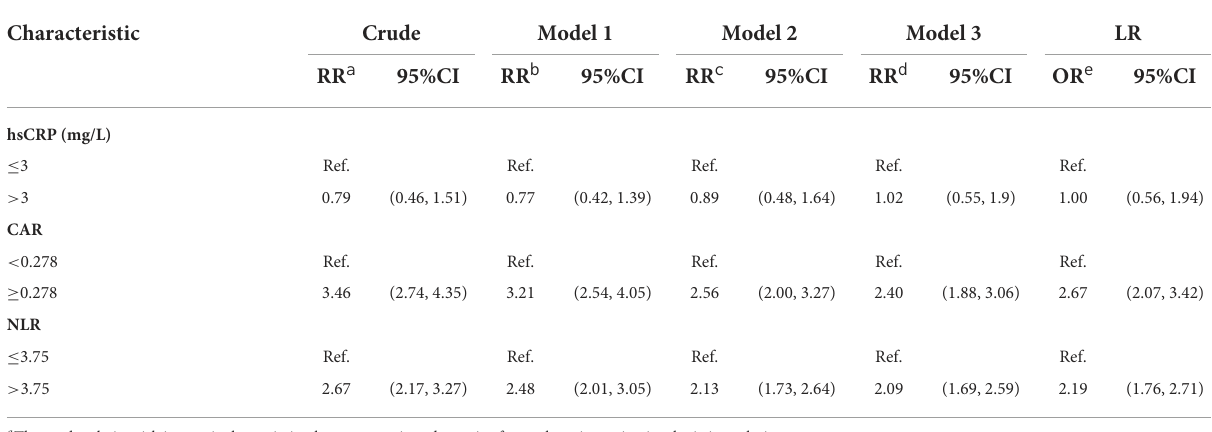
method of Mantel-Haenszel based on the model 1, model 2, and model 3 gave very close answers except